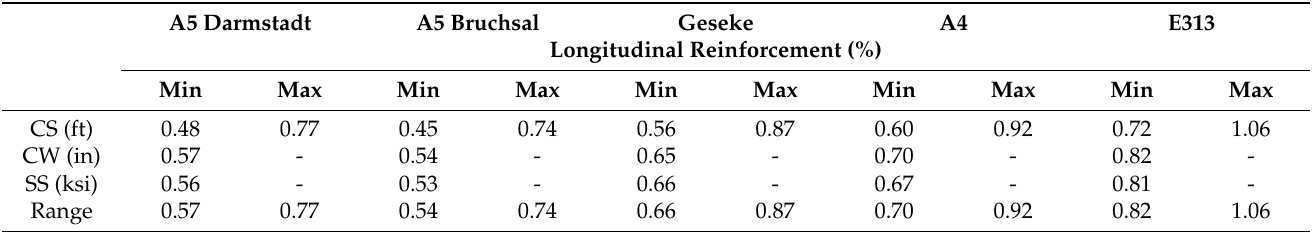
Table 2. Design criteria and required range of steel percentage based on AASHTO